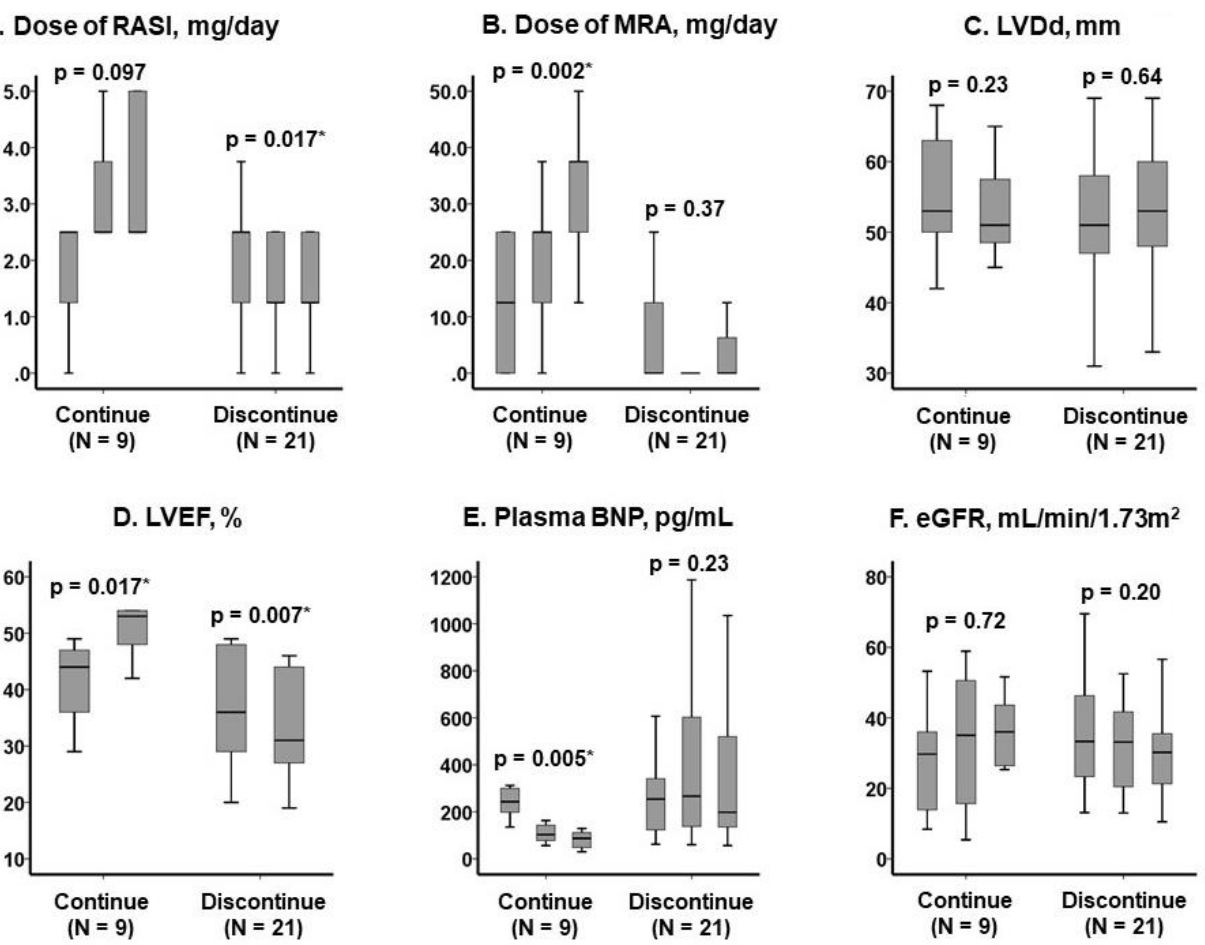
Figure 2. Trends of clinical variables including dose of RASIs ( A ), MRAs ( B ), LVDd ( C ), LVEFs ( D ), plasma BNP levels ( E ), and eGFRs ( F ) in the SZC continue group and the SZC discontinue group. Data were followed at baseline, 1 month, and 3 months later in medication doses and laboratory data ( A , B , E , and F ). Data were followed at baseline and 3 months later for echocardiography data ( C and D ). * p < 0.05 by Friedman tests for trend analyses. RASI, renin-angiotensin system inhibitor; MRA, mineralocorticoid receptor antagonist; LVDd, left ventricular end-diastolic diameter; LVEF, left ventricular ejection fraction; BNP, B-type natriuretic peptide; eGFR, estimated glomerular filtration ratio.